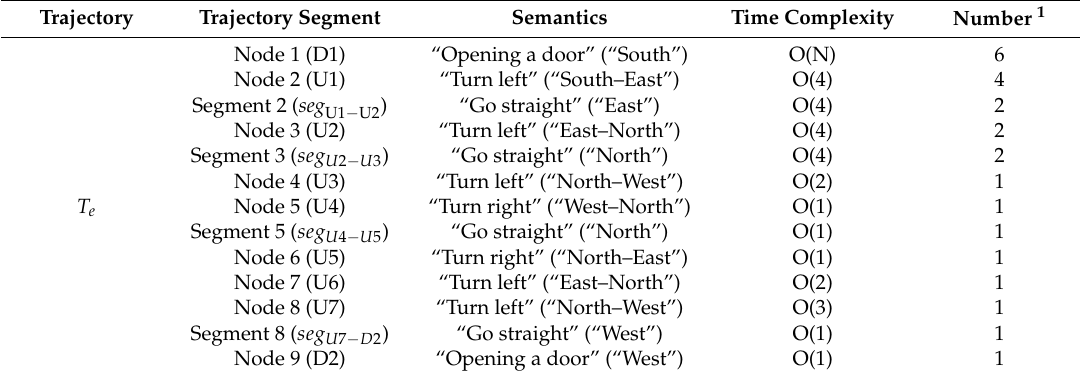
Table 2. Semantic matching results.